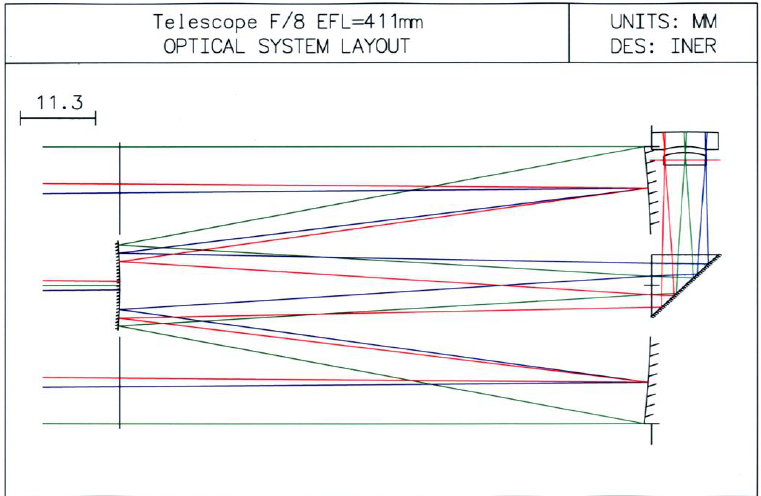
Figure 1. A reflecting type Cassegrain telescope–optical